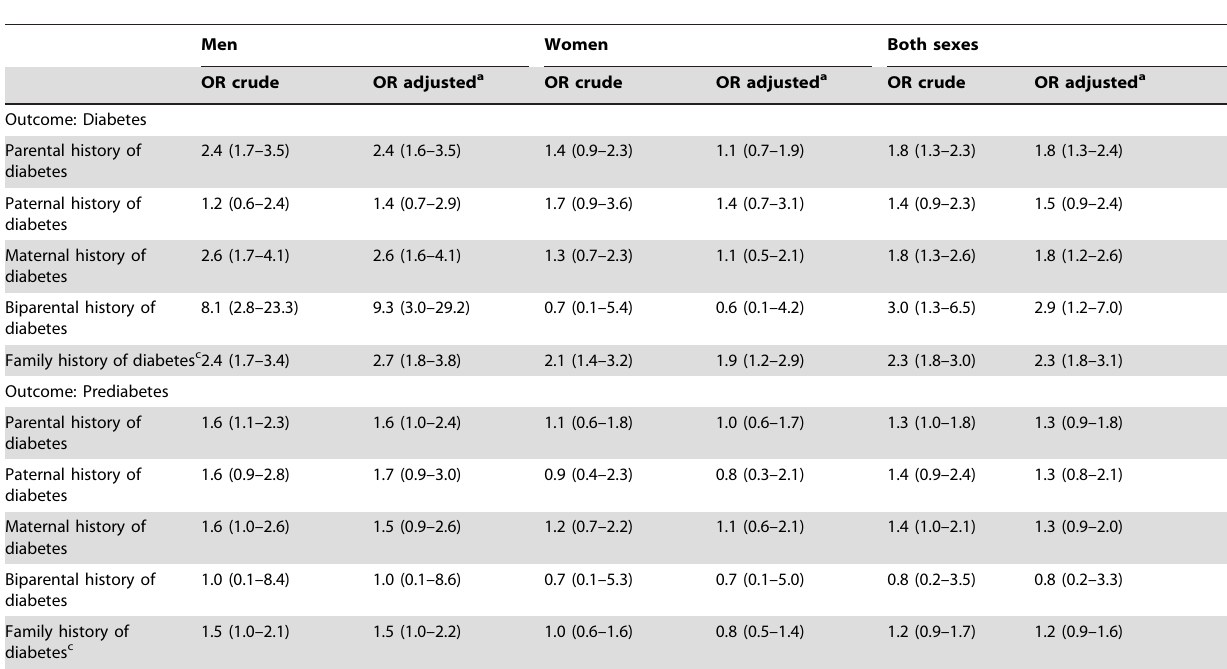
Table 2. Prevalence odds ratios of diabetes and prediabetes associated with a parental history of diabetes.